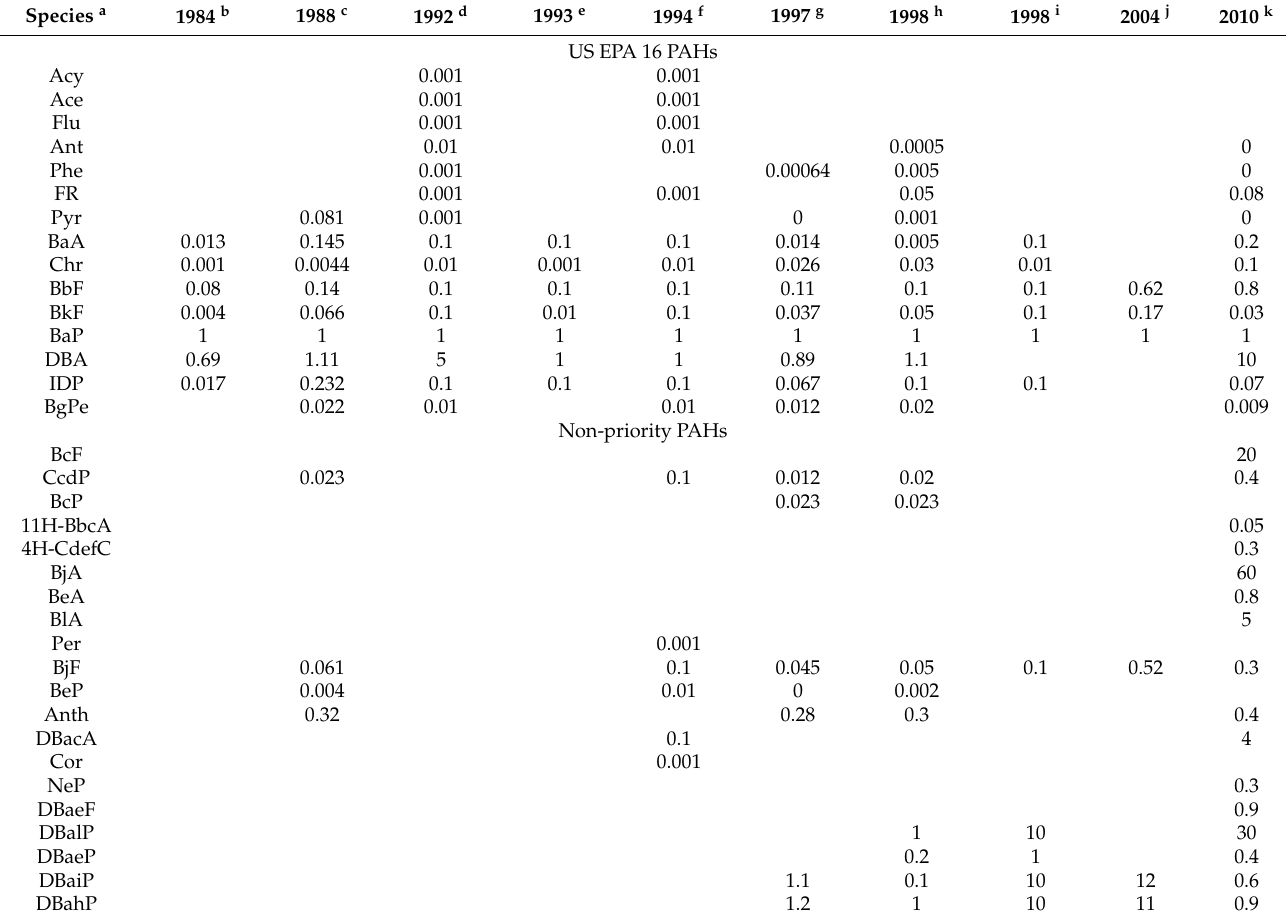
Table 7. Reference data of certain PAHs regarding their cancer risks based on BaP. Species